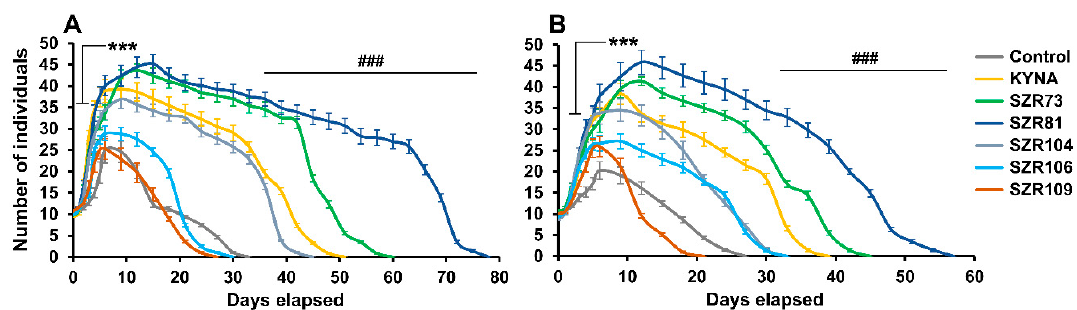
Figure 2. Survival kinetics of rotifer populations treated (100 µM) with KYNA or its analogs. The number and survival of individuals significantly increased in the three treated groups compared to untreated controls. KYNA and its SZR73 and SZR81 analogs had the most beneficial effect on both Philodina acuticornis ( A ) and Adineta vaga ( B ) species. The two different bdelloid rotifer genera show similar kinetics under the same treatments. The error bars represent SEM. One-way ANOVA with Bonferroni post hoc test was used for statistical analysis, the level of significance is ***; ### p < 0.001 (*, significant difference in number of rotifers from untreated controls on day nine; # significant difference from untreated control in survival of animals; n = 12 wells).